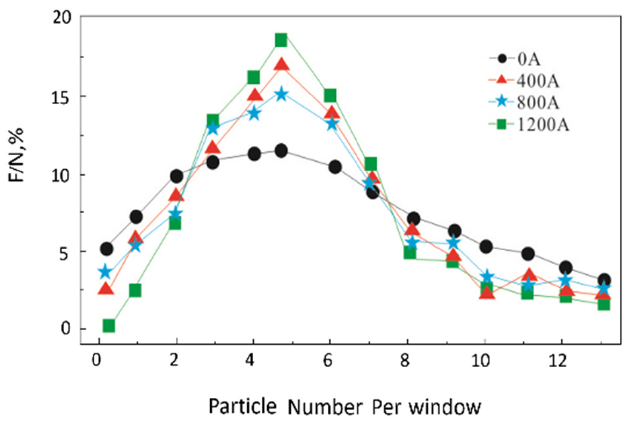
Figure 5. Grain size distribution of SiC under different pulse current conditions.